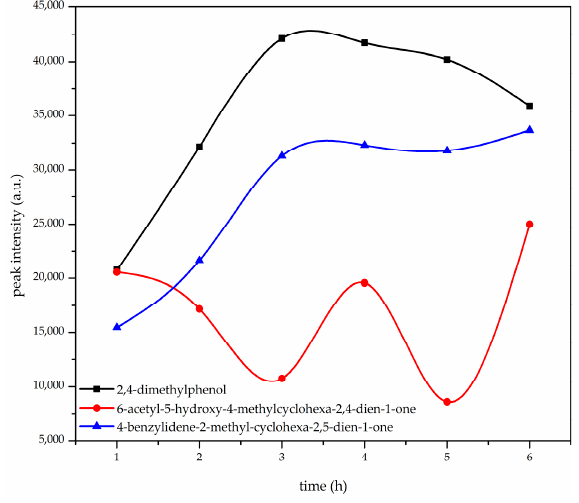
Figure 8. Relative peak intensities of degradation products identified by GCMS analysis.